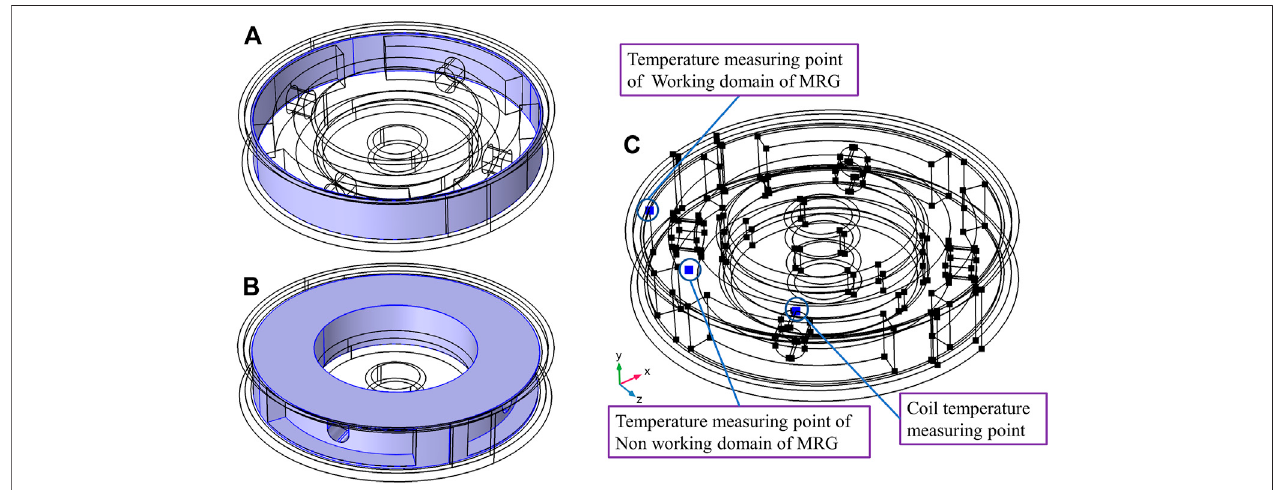
FIGURE 8 | Simulation model of transient temperature fi eld: (A) working domain of the MRG, (B) non – working domain of the MRG, and (C) temperature probe picking point.